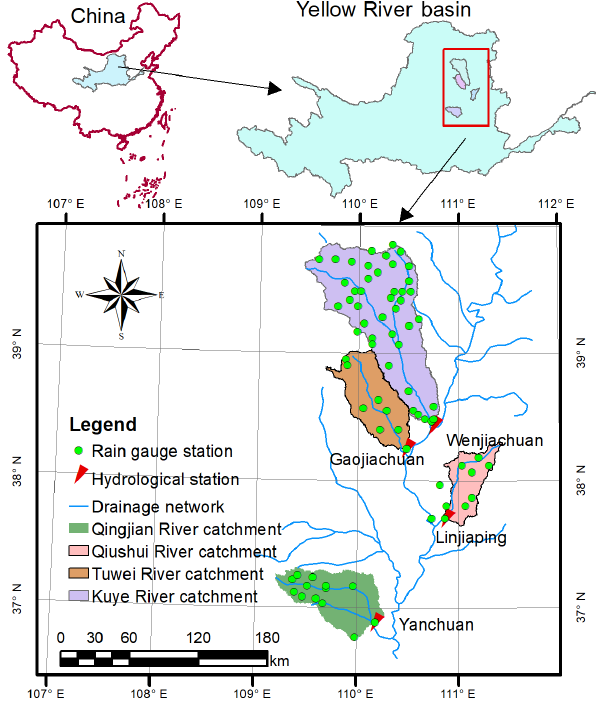
Figure 1. Locations and rain gauging nets of the Qingjian River catchment, Qiushui River catchment, Tuwei River catchment and Kuye River